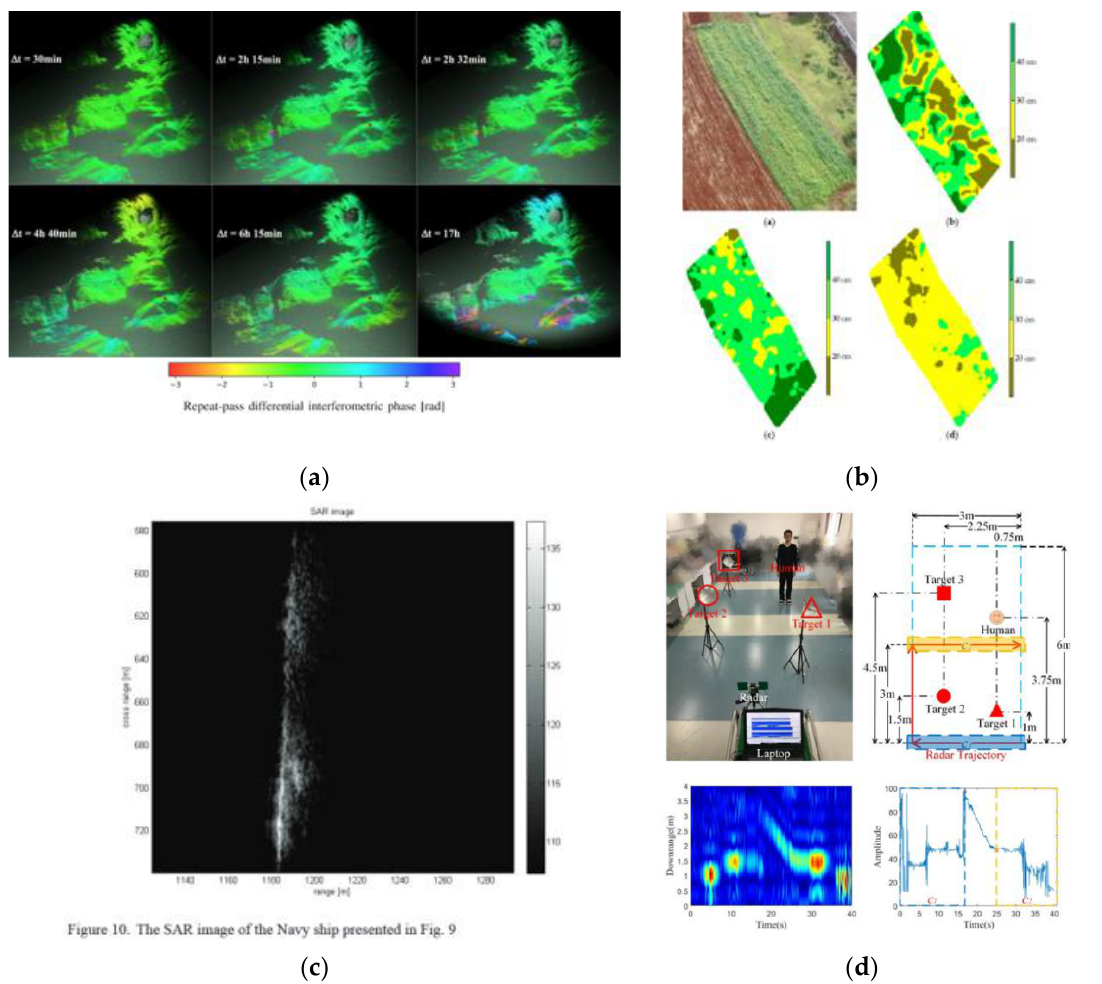
Figure 18. Examples of SAR applications: ( a ) Interferometry (after [14]); ( b ) agriculture (after [71]); ( c ) moving target identification (after [74]); ( d ) vital sign detector (after [76]).